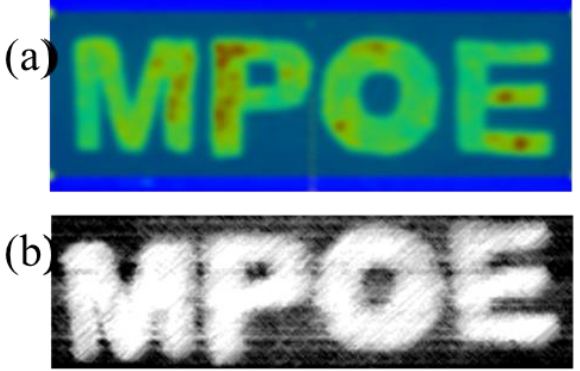
Figure 8. ( a ) Persistent luminescence image from the “MPOE” pattern, hand painted using ZGSO-3: Ni 2+ , Er 3+ , Cr 3+ NPs detected with Si-based visible camera; ( b ) persistent luminescence image from the “MPOE” pattern, hand printed using ZGSO-3: Ni 2+ , Er 3+ , Cr 3+ NPs, detected with InGaAs-based NIR camera.